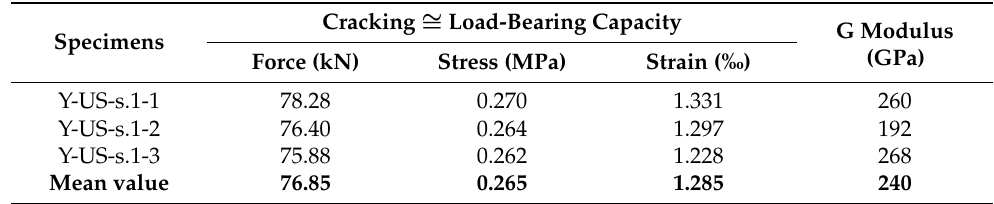
Table 4. Specific values characterized the unstrengthened walls.